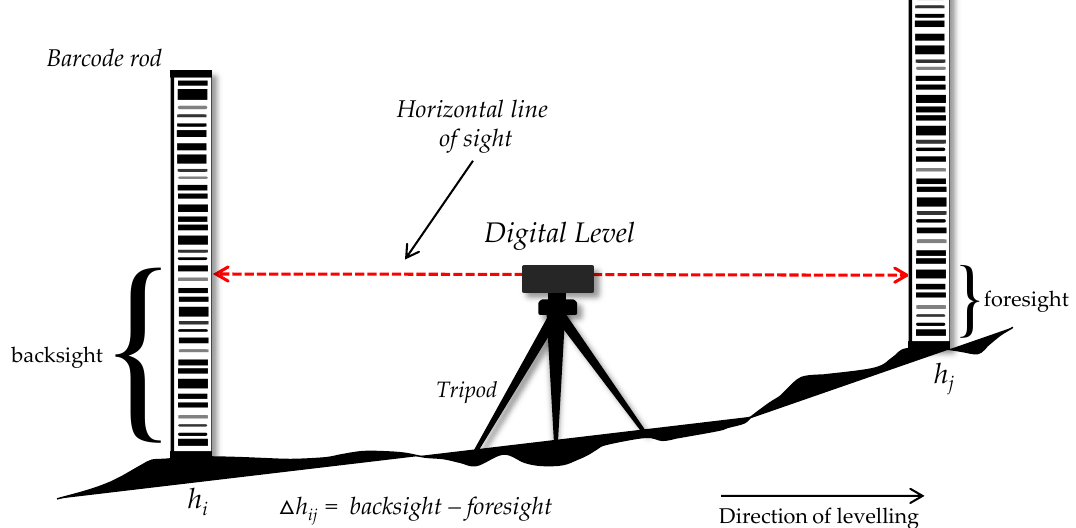
Figure 3. Example of levelling for a single line: the digital level instrument is placed between the points whose height difference is to be found. Special barcoded staffs are placed at these points and then sighted through the digital level